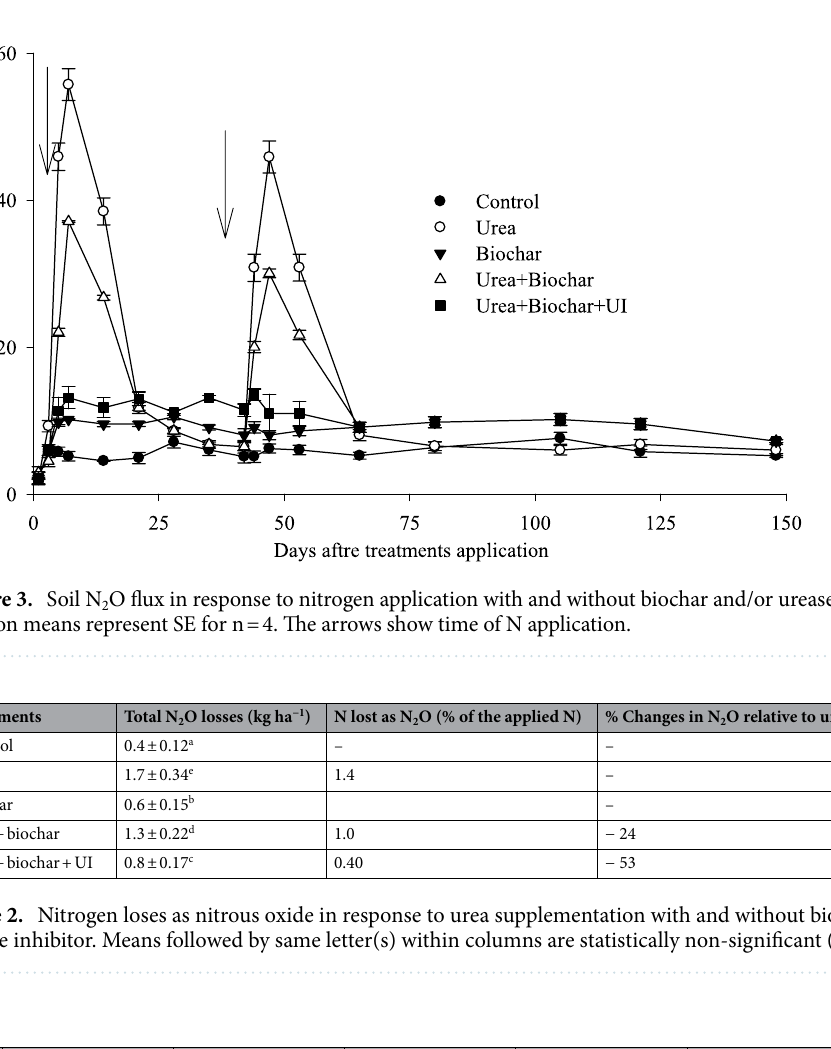
Table 2. Nitrogen loses as nitrous oxide in response to urea supplementation with and without biochar and/or urease inhibitor. Means followed by same letter(s) within columns are statistically non-significant (p < 0.05).